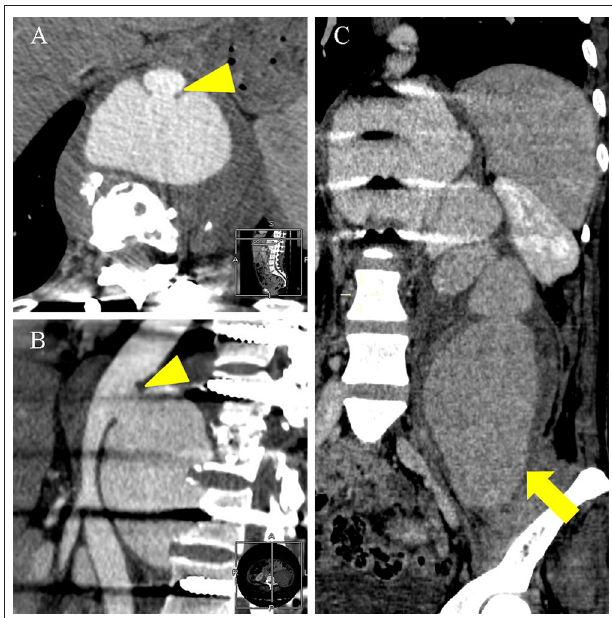
FIGURE 3 | An enhanced CT scan on 1 December 2021 showed a pseudoaneurysm measuring 8.2 × 5.2 × 22.9cm. (A,B) Axial and lateral enhanced CT scan showed the thoracic aorta communicated with the pseudoaneurysm through the rupture (arrowhead). (C) Coronal enhanced CT scan showed the pseudoaneurysm significantly enlarged into the left iliac fossa (thick arrow) compared with Enhanced MRI scan on 6 November